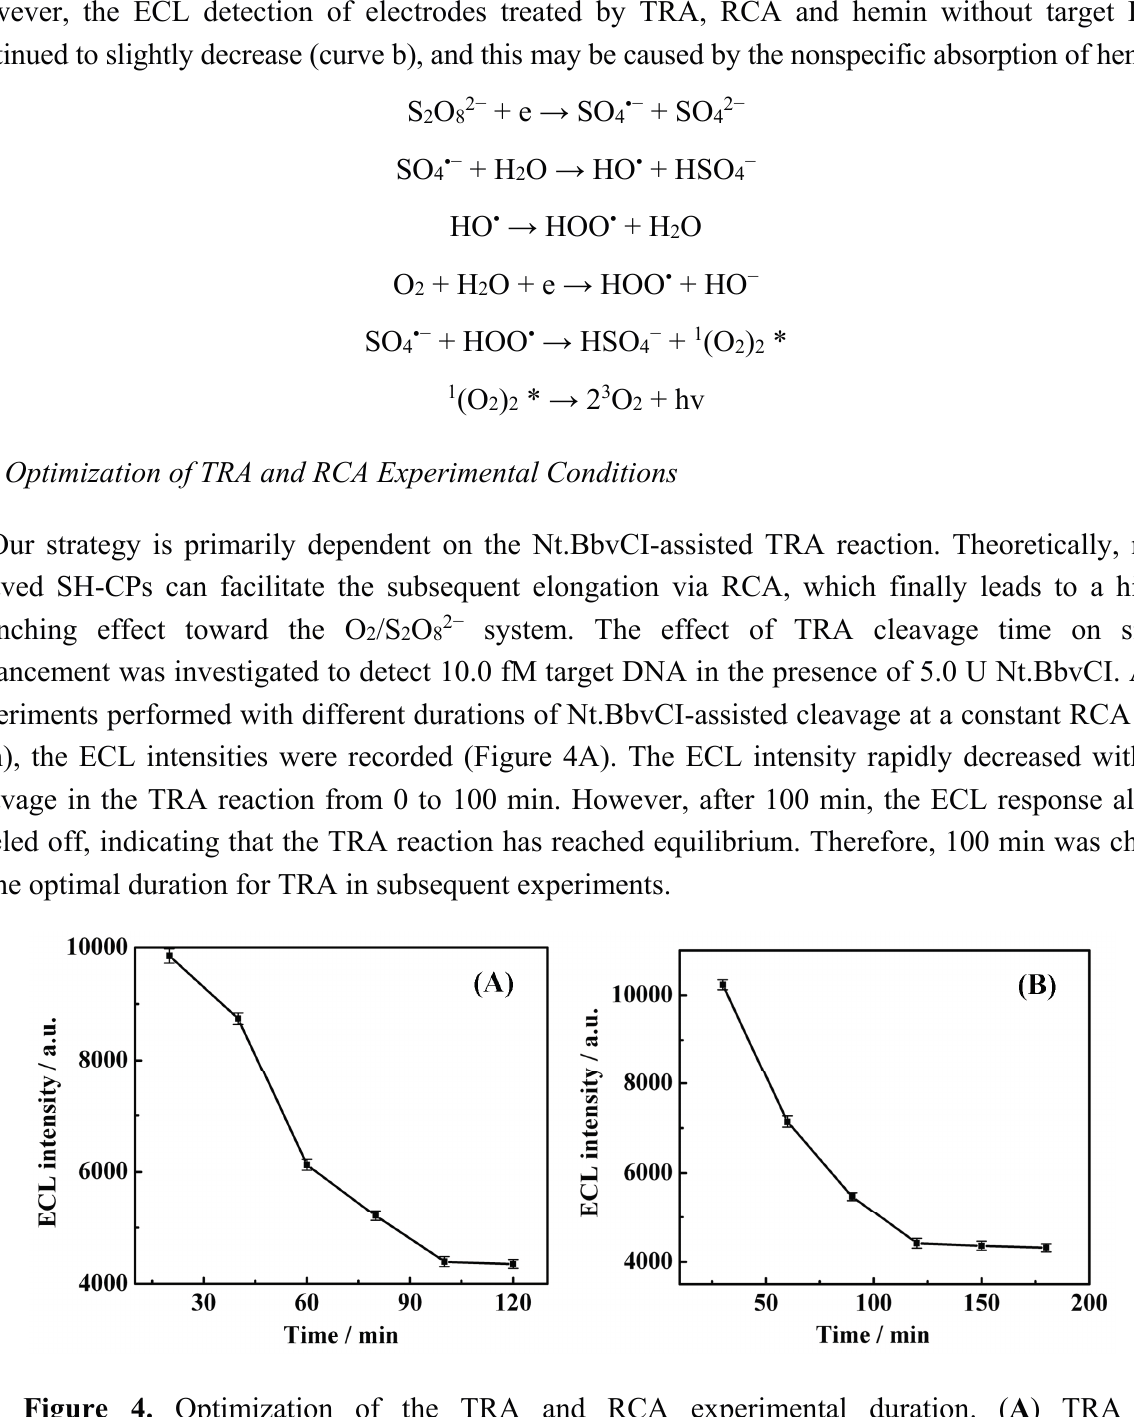
Figure 4. Optimization of the TRA and RCA experimental duration. ( A ) TRA duration-dependent ECL intensity; ( B ) RCA duration-dependent ECL intensity